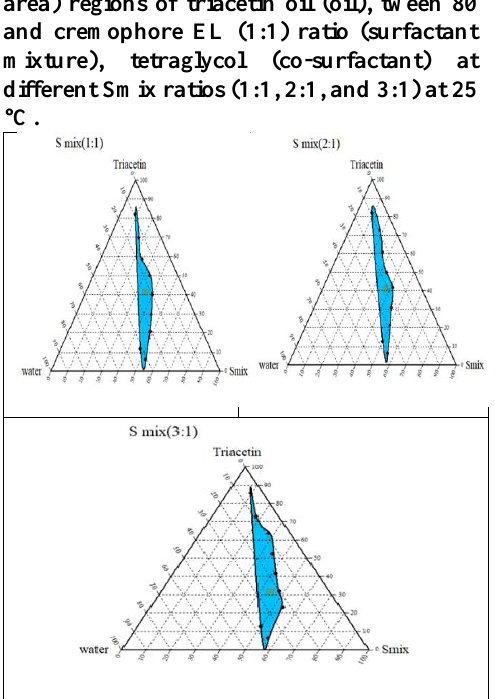
Figure 2. Pseudo-ternary phase diagrams showing the (o/w) nanoemulsion (colored area) regions of triacetin oil (oil), tween 80 and cremophore EL (3:1) ratio (surfactant mixture), tetraglycol (co-surfactant)